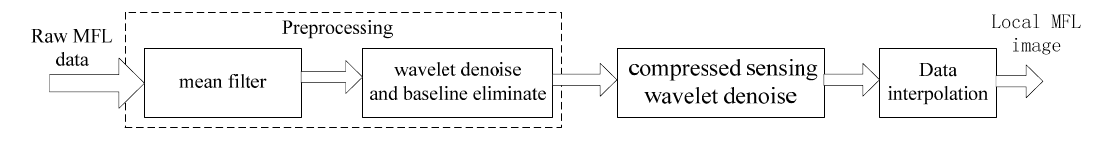
Figure 3. Signal preprocessing flowchart.